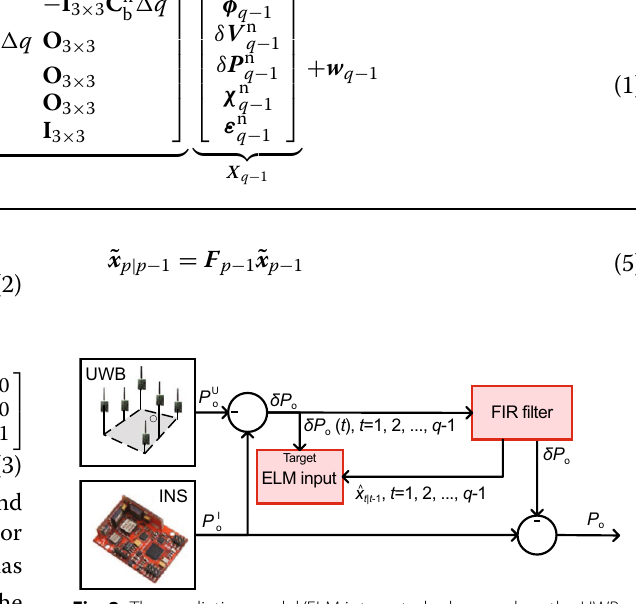
Fig. 2 The predictive model/ELM integrated scheme when the UWB